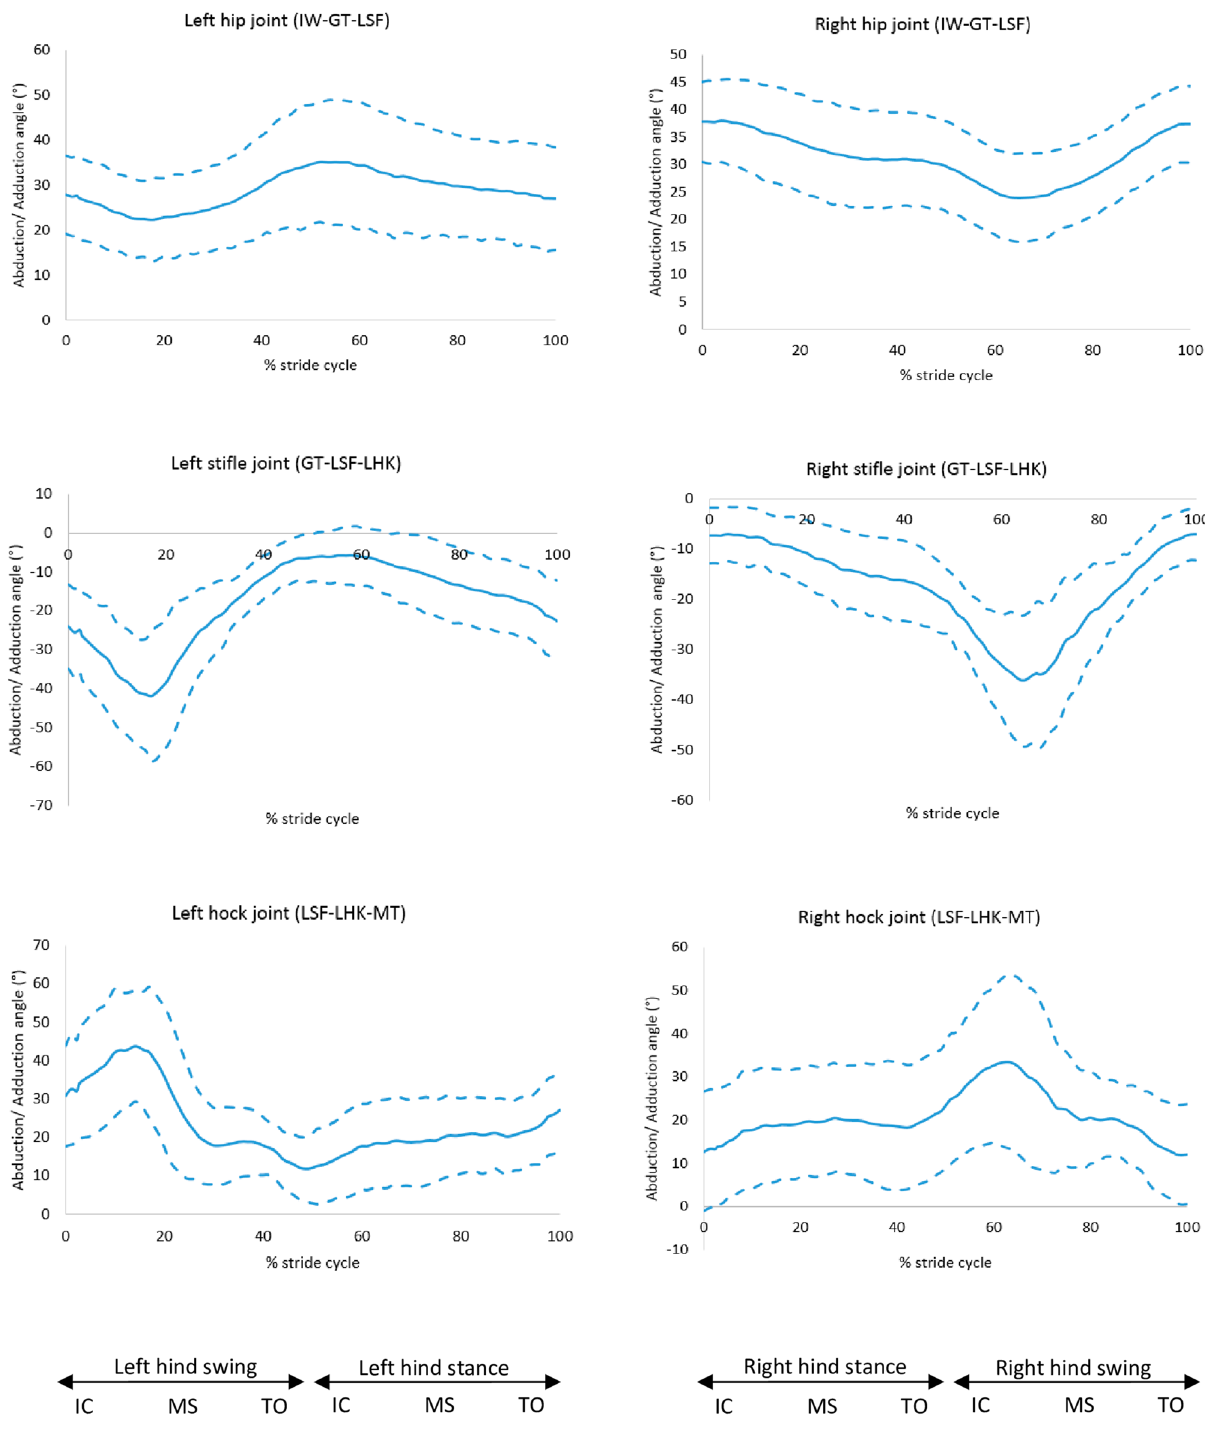
Figure 10. Abduction (positive) and adduction (negative) angles for the hindlimb joints, mean of 30 GSDs (solid line) and showing one standard deviation from the mean (dashed lines). Graphs are plotted for one stride cycle, showing initial contact (IC), Mid Stance (MS) and Toe Off (TO) for the left and right diagonals. The three reflective markers tracked and used to compute the joint angle is shown in the brackets. Between brackets: marker names (Supplementary material 3,